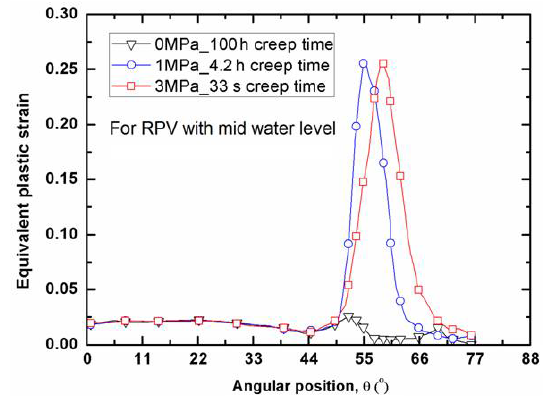
Figure 7. Effect of internal pressure on plastic strain distribution for RPV with mid water